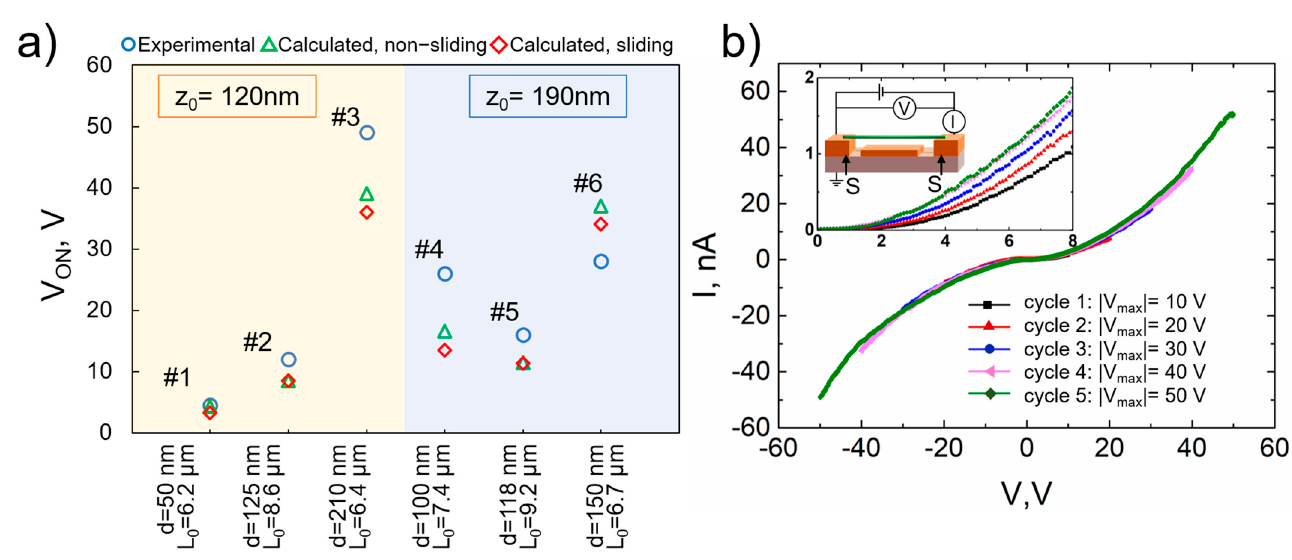
Figure 4. ( a ) Comparison of experimentally determined and calculated V ON values for six samples (labeled 1 . . . 6) with different nanowire diameter d and suspended length L 0 values and two initial distances between the nanowire and the electrode z 0 (120 nm and 190 nm). V ON was calculated for two different cases: with and without sliding of the nanowire ends. ( b ) I–V cycling characteristics of a single device (#6) with voltage applied between S contacts. I–V cycling starts—from maximum voltage absolute value |V max | of 10 V. The absolute value of maximum voltage is increased during every next cycle. Inset zooms in on the I–V plots for voltages up to 8 V, showing a reduction of contact resistance.